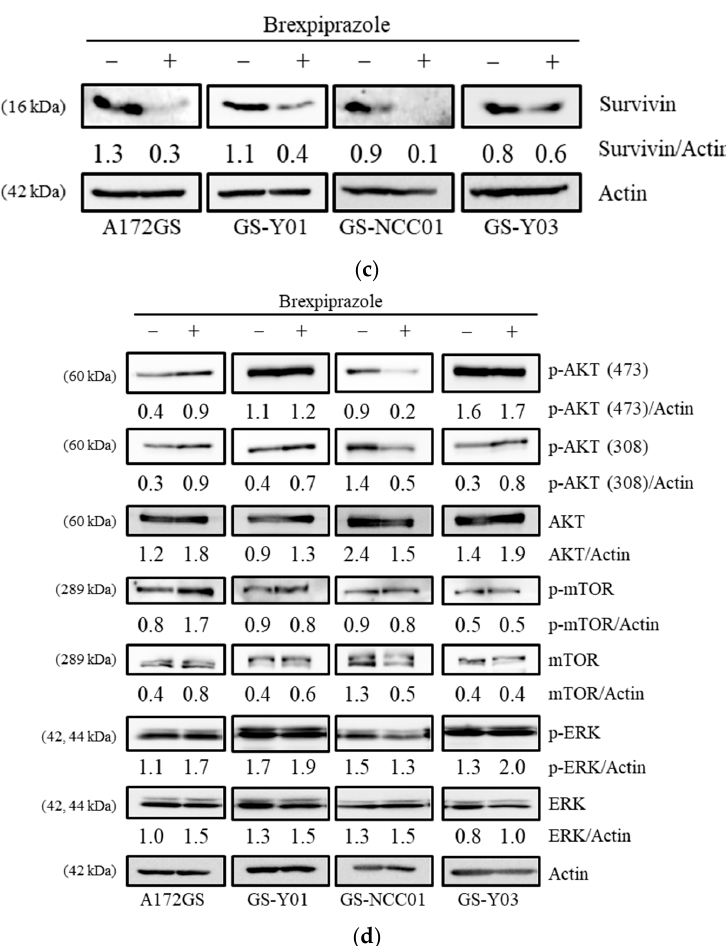
Figure 1. The effects of osimertinib and brexpiprazole combination treatment on glioma stem cell (GSC) proliferation and survivin expression: GSCs (A172GS, GS-Y01, GS-NCC01, and GS-Y03) were treated with or without 1.5 μ M of osimertinib and with or without 3 μ M of brexpiprazole for 3 days and were then subjected to several analyses. ( a ) The cells were subjected to cell viability assay using WST-8. Values represent means + SD from quadruplicate samples of a representative experiment repeated with similar results. * p < 0.05. ( b ) The cells were subjected to cell death assay using Hoechst 33342 (Hoechst) and propidium iodide (PI). The upper graphs show the proportion of dead cells as means + SD from triplicate samples of a representative experiment repeated with similar results. * p < 0.05. The lower panels show representative phase contrast images, Hoechst-positive images (total cells), and PI-positive cells (dead cells) among GS-Y01 cells. Scale bar: 200 μ m. ( c,d ) The cells were subjected to immunoblot analysis for survivin, p-AKT, AKT, p-mTOR, mTOR, p-ERK, and ERK.